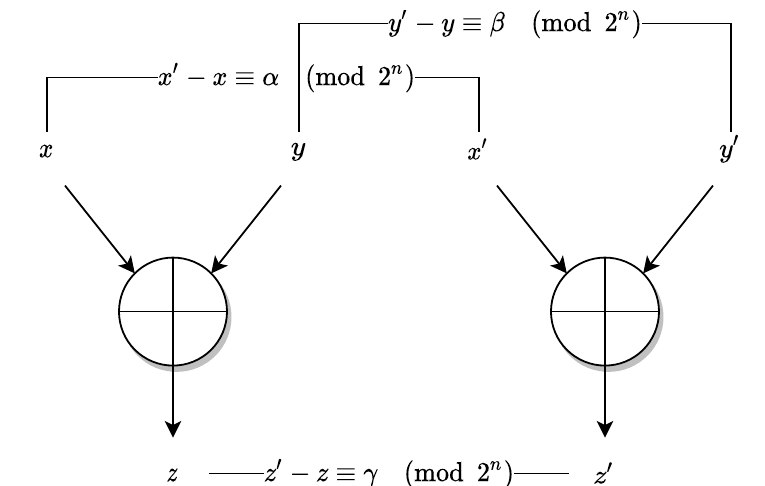
Figure 1: The differential probability adp ⊕ ( α, β → γ ) of exclusive-or when differences are represented using differences α, β, γ are expressed using addition modulo 2 n . The probability is obtained by averaging over all values of x and y